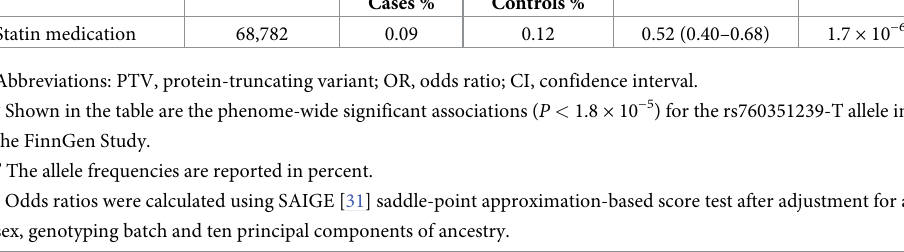
lipid genes, a genome-wide significant association between a PTV in ANGPTL8 and triglycer- ide levels has not previously been reported in humans. ANGPTL8 is known to inhibit triglyc- eride-hydrolyzing lipoprotein lipase [26,27]. In our data, the association between ANGPTL8 PTV and lower triglyceride levels had the strongest effects soon after a meal in a post-prandial state, and after prolonged fasting. These findings are in line with animal studies which show that Angptl8 is secreted after feeding and has a very short half-life [23,24], and that hepatic very low-density lipoprotein (VLDL) secretion is decreased in Angptl8 knockout mice [28]. Our results also show that carriers of a Finnish-enriched ANGPTL8 PTV had 47% lower odds of CAD than noncarriers. This is in line with genetic evidence of triglycerides being a